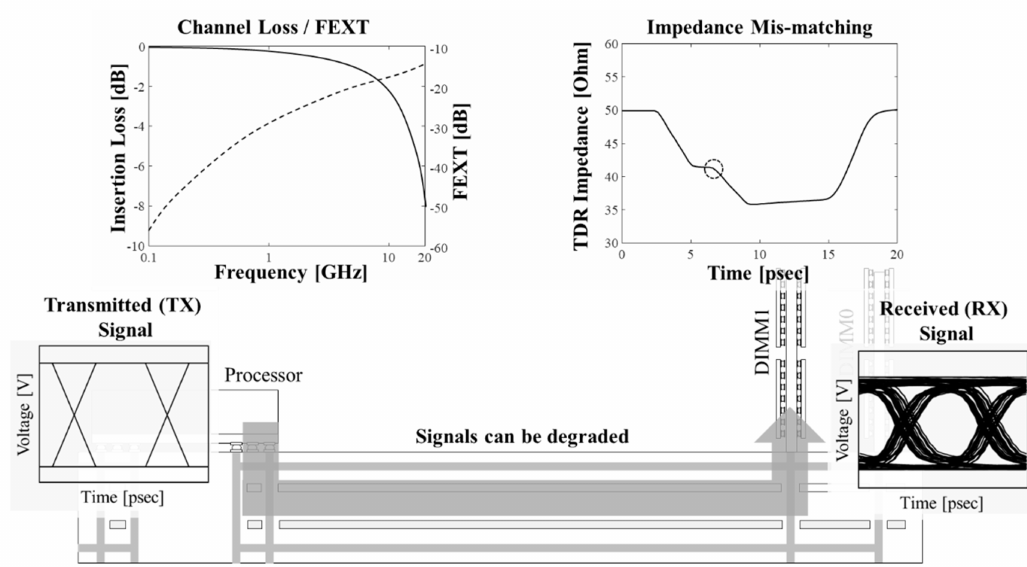
Figure 1. In the memory signaling system, the signal integrity (SI) issues of the high-speed signaling channel are shown. The received signals are degraded due to channel loss, far end crosstalk, and channel impedance mismatching. Thus, the design of the high-speed signaling channel must consider these SI issues.